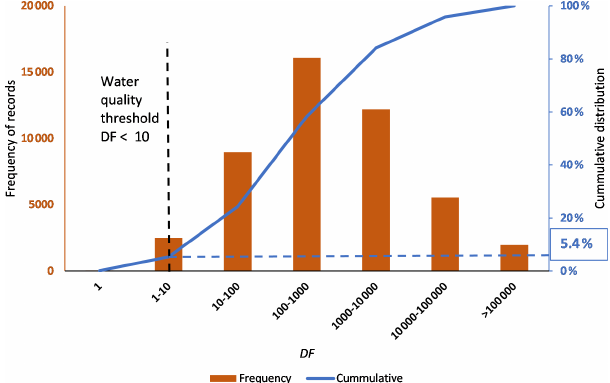
Figure 5. Frequency distribution of calculated dilution fac- tors (DFs) at average-flow conditions of all WWTPs in the HydroWASTE database (with some exceptions, see text for more information). For results at low-flow conditions, see Fig.